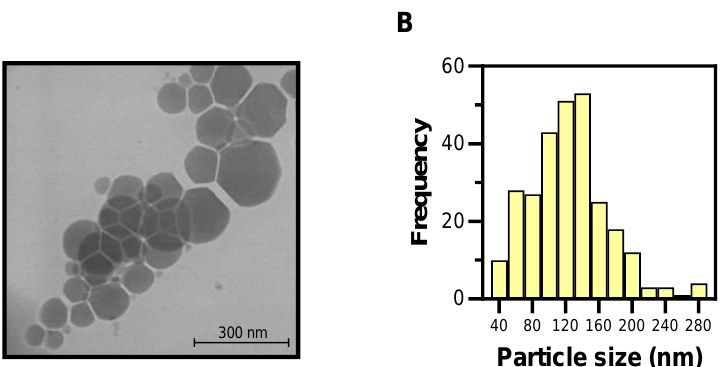
Figure 6. ( A ) STEM photograph of empty LNLCs M3 at 200 kV × 80.00 k. ( B ) Size distribution histogram of empty LNLCs